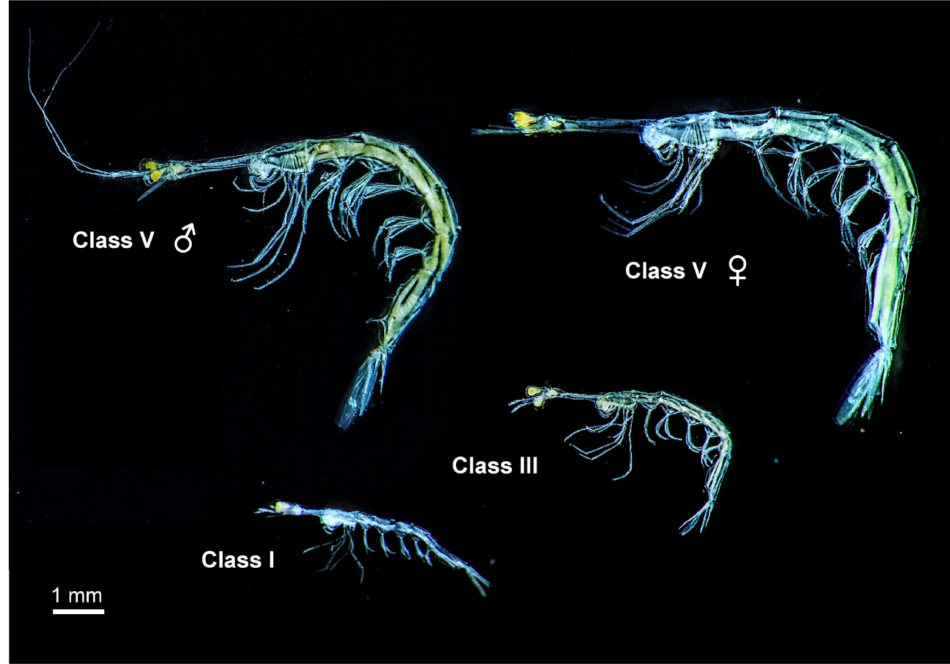
Figure 8. Belzebub faxoni . Habitus in lateral view from size classes I, III, and